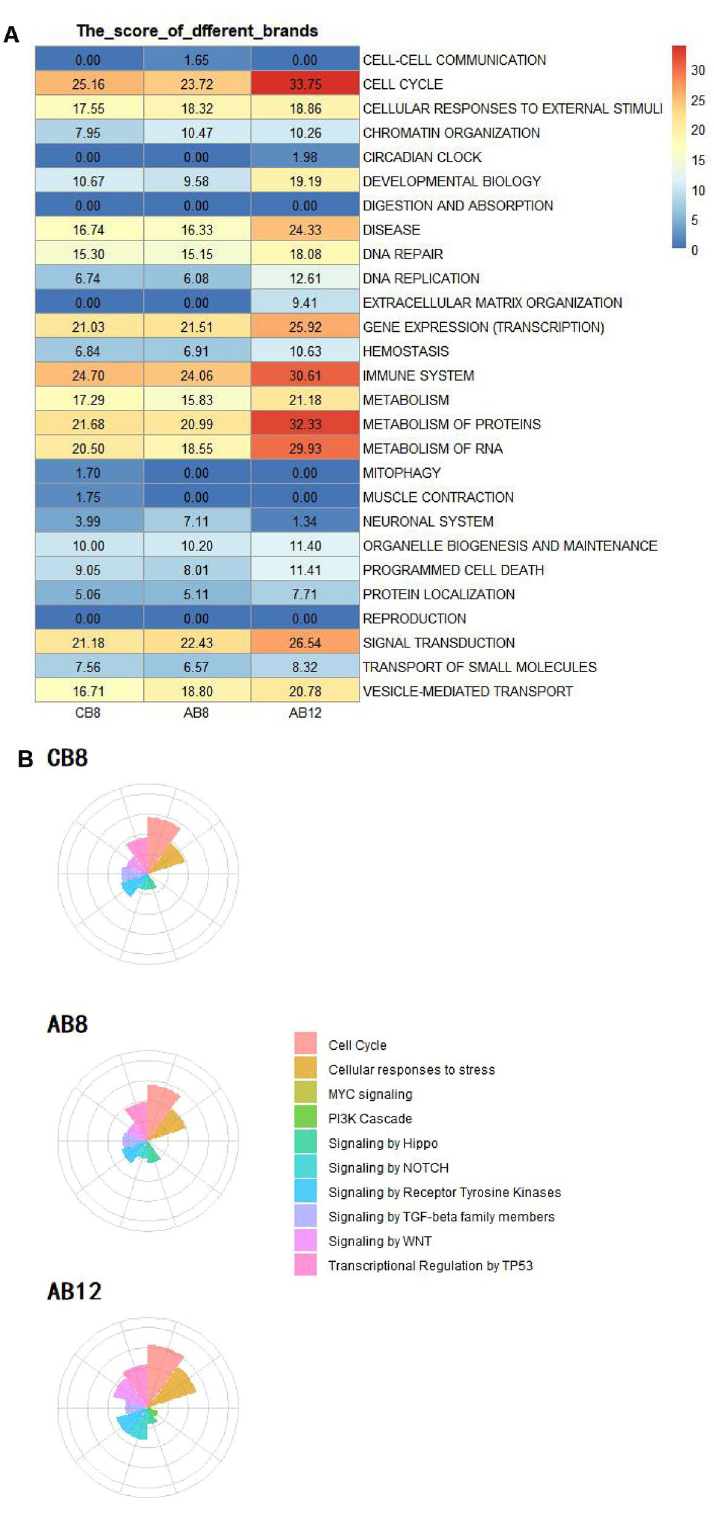
Figure 6. Application of SPPA algorithm in comparisons of the biological impact of MS from cigarettes with different contents of tar/nicotine. A The degree of effect of CB8, AB8 and AB12 smoke exposure on 27 cell- related topics at different time points. The redder the color, the higher the effect score. B The Z-score values of ten cancer-related pathways under CB8, AB8 and AB12 treatment using SPPA algorithm. The larger the sector area, the larger the Z-score value, indicating the greater the perturbation to the pathway. Two commercial cigarettes with different labeled tar contents, CB8 (8 mg) and AB8/AB12 (8 and 12 mg), were produced by two different tobacco